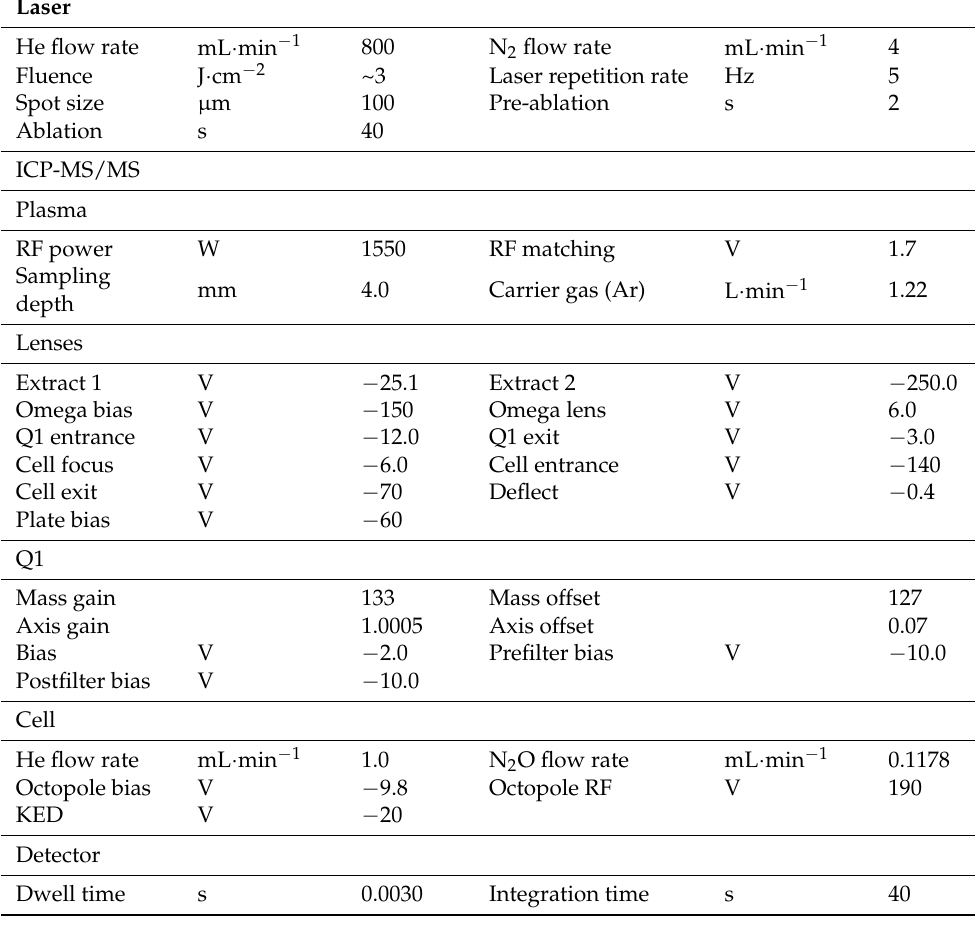
Table 1. Typical analytical parameters used throughout this work. Ion lenses and acceleration voltages were optimized at the beginning of every day of the experiment (see text), so actual values may vary slightly from one experiment to another.